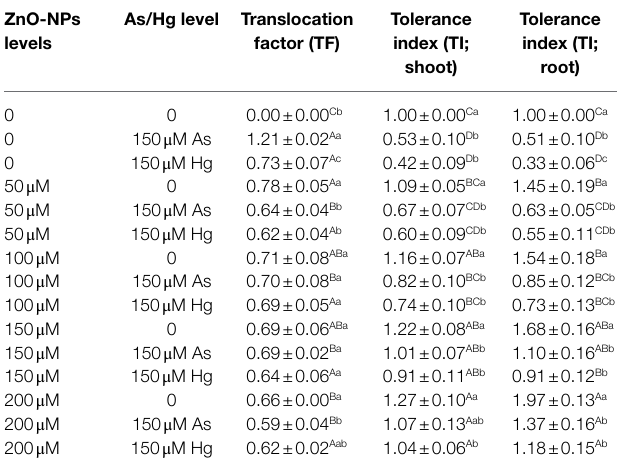
TABLE 4 | The change in translocation factor (TF) and tolerance index (TI) in shoot and root at different concentrations of ZnO-NPs in combination with 150 μ M As and 150 μ M Hg compared to those of the control